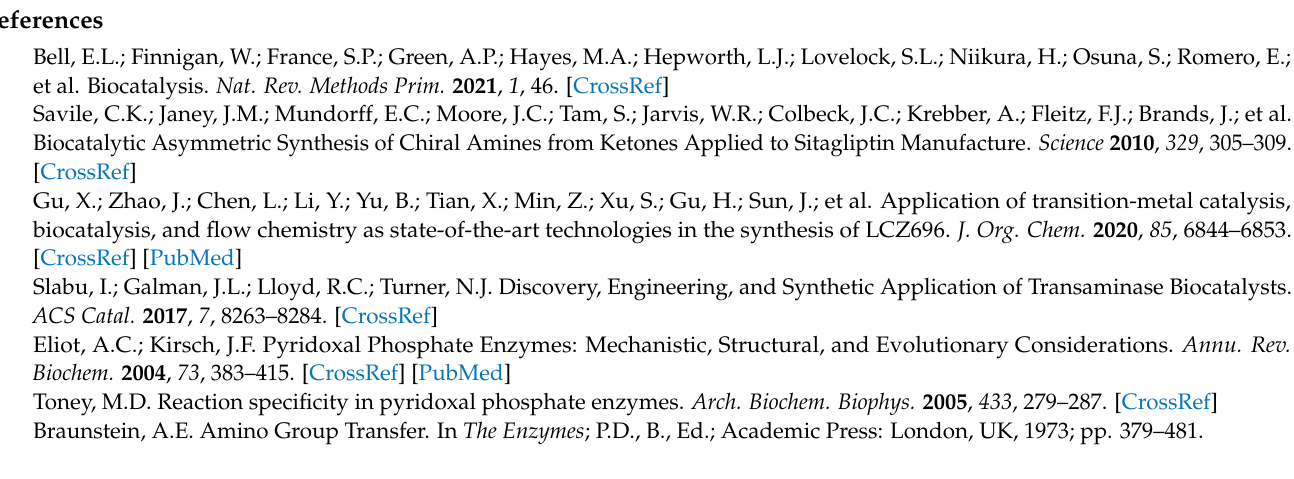
Figure S7: The gel filtration elution profile for Amico TA; Figure S8: Binding of PLP molecule in the